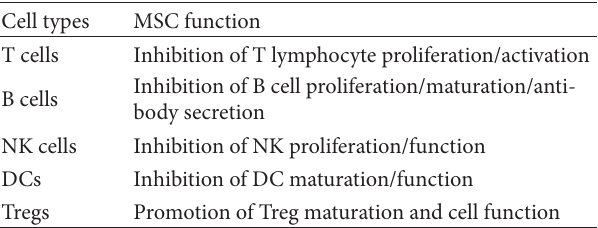
Table 2: Immunosuppressive functions of BM MSCs on various immune cell